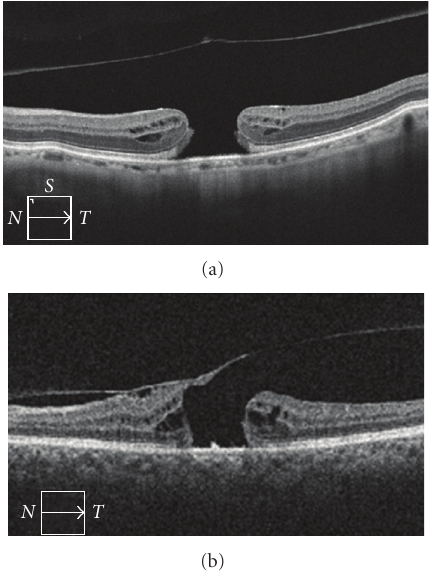
Figure 1: Optical coherence tomography of full-thickness macular holes (a) with separation of the posterior vitreous from the fovea and (b) with vitreomacular traction. Note the di ff erence in foveal contour, as well as the presence of intraretinal